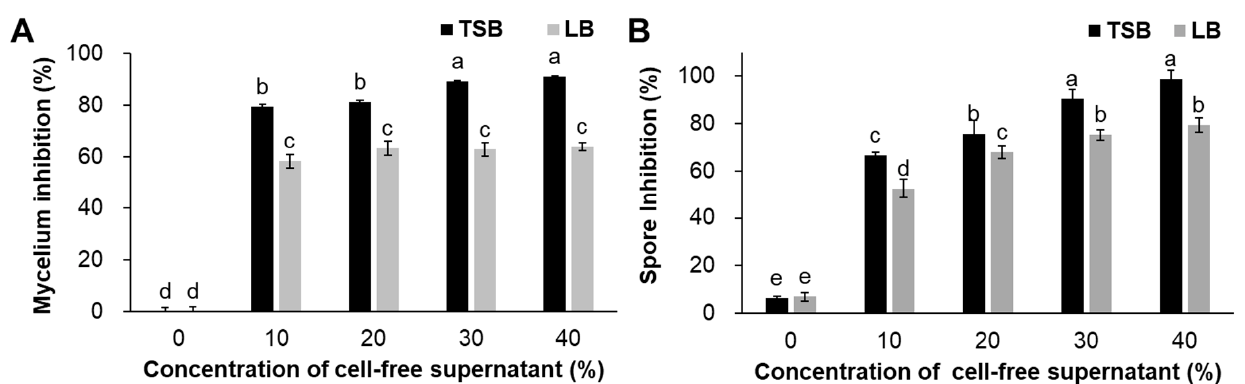
Figure 3. Effects of cell-free supernatants of B. subtilis KB21 on inhibition of ( A ) mycelial growth and ( B ) spore germination of Colletotrichum acutatum . The mycelium inhibition rate of the KB21 culture filtrate was calculated using the following formula: mycelia growth inhibition rate (%) = (A-B)/A × 100, where A is mycelial growth on control (0%) PDA and B is growth on PDA plates containing cell-free supernatant (10–40%). The spore germination rate calculation was as follows: spore germi- nation rate (%) = (number of germinated spores/total number of observed spores) × 100. Data repre- sent means ± standard errors of three replicates. The values followed by different letters in a column were significantly different at p < 0.05 by Duncan’s multiple range test. 10, 20, 30, 40, PDA amended with different concentrations of B. substilis KB21 culture filtrate; 0, control (PDA without Bs KB21